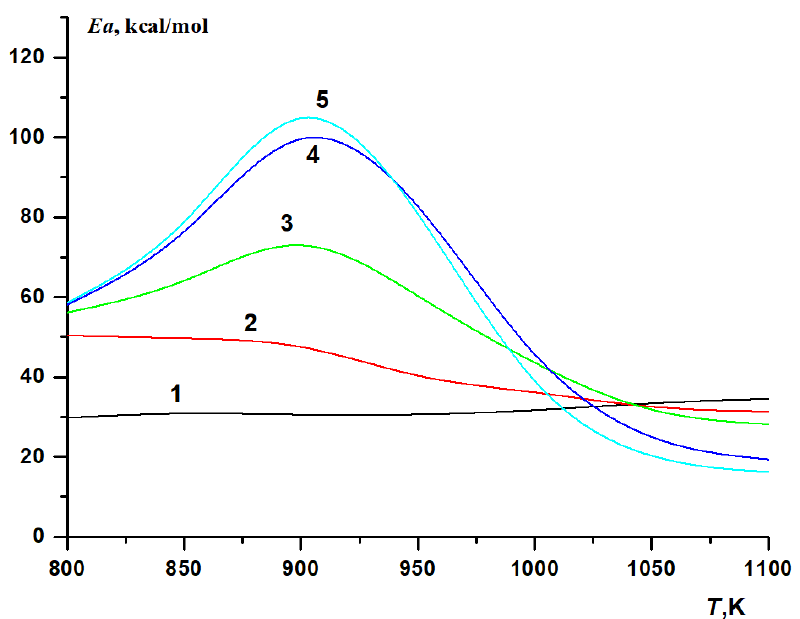
Figure 5. Calculated temperature dependence of the effective activation energy E a for the autoigni- tion delay time of stoichiometric CH 4 ‒H 2 ‒air mixtures on the initial temperature at various hydro- delay time of stoichiometric CH 4 –H 2 –air mixtures on the initial temperature at various hydrogen gen concentrations (%): 0 ( 1 ), 40 ( 2 ), 70 ( 3 ), 90 ( 4 ), 100 ( 5 ). P 0 = 1 atm. concentrations (%): 0 ( 1 ), 40 ( 2 ), 70 ( 3 ), 90 ( 4 ), 100 ( 5 ). P 0 = 1